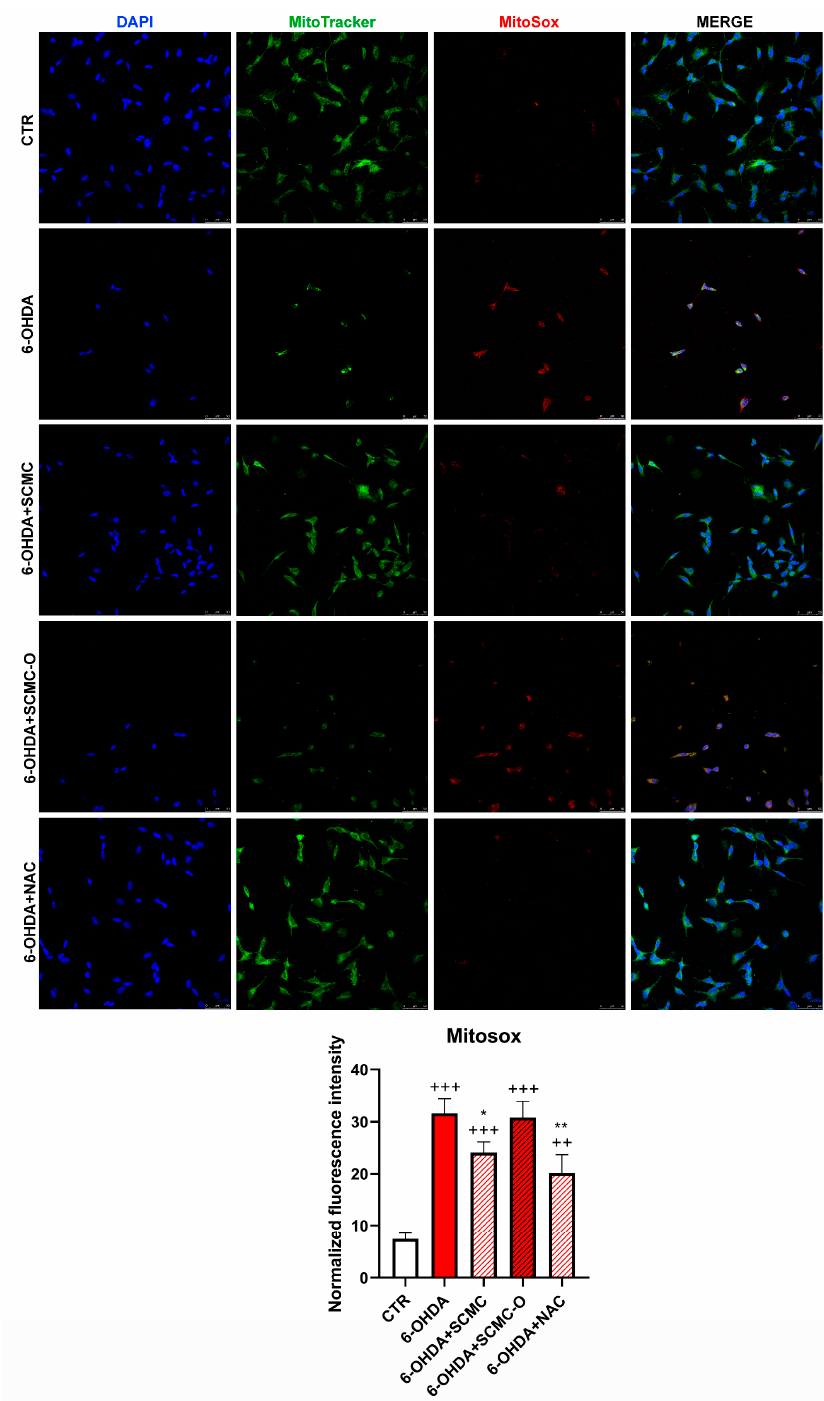
Figure 6. Mitotracker green with Mitosox. The graph shows the normalized fluorescence intensity MitoSox/Mitotracker normalized on nuclei. Data are mean ± SD of three different experiments. *: p < 0.05; **: p < 0.005 vs. 6-OHDA; ++: p < 0.005; +++: p < 0.0001 vs. CTR. Scale Bar: 50 µ